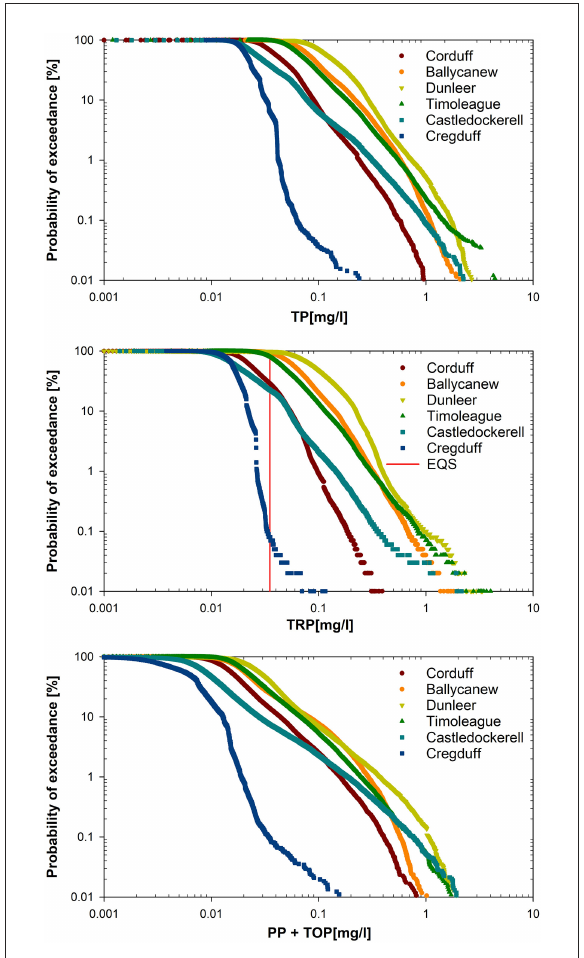
FIGURE3 The probability of exceedance (percent time) for TP, TRP and PP + TOP concentrations in the six study catchments for ten hydrological years (1st October 2010 to 30th September 2020) based on hourly average concentrations. The Environmental Quality Standard (EQS) of 0.035mg TRP/l is marked with a vertical red